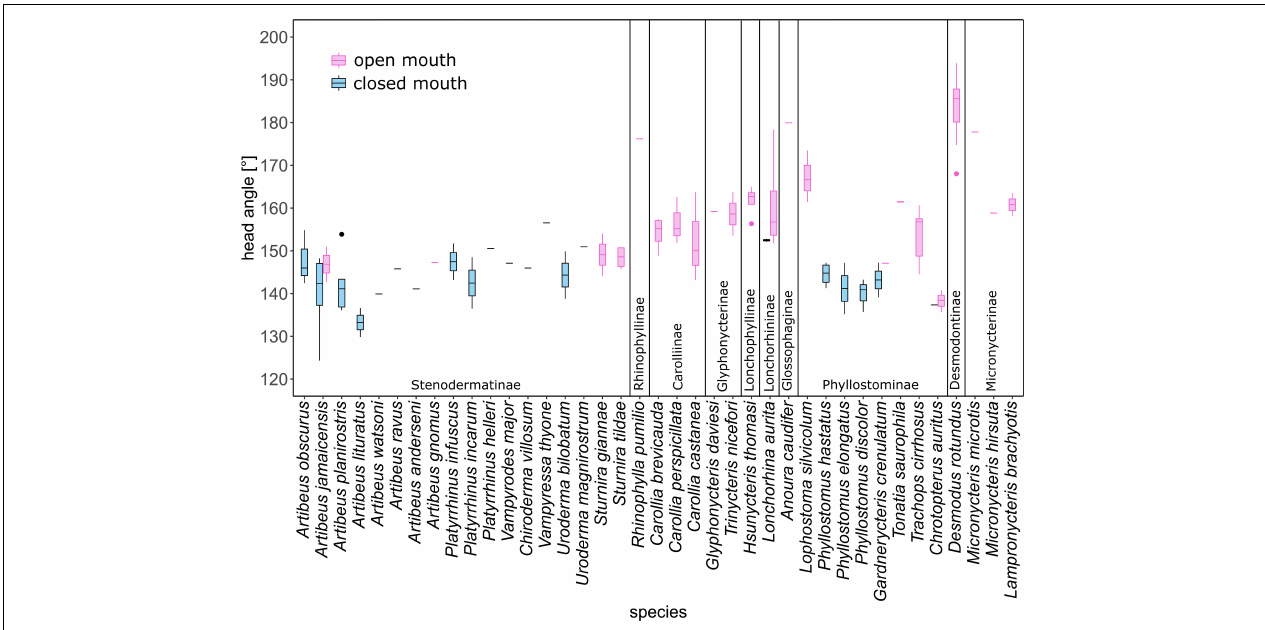
FIGURE 5 | Boxplots of mean head position angle per species. Vertical lines separate subfamilies. Open-mouth species held the head straighter (mean = 159 ◦ ± 12) than individuals with closed mouths (nasal emitters) (mean = 183 ◦ ± 8). The box incorporates the middle 50 % of the data and the line within the box the median value. Whiskers mark the 25th percentile and the 75th percentile of the data (range of the data). Outliers (values more than 1.5 times the interquartile range beyond either end of the box) are plotted as